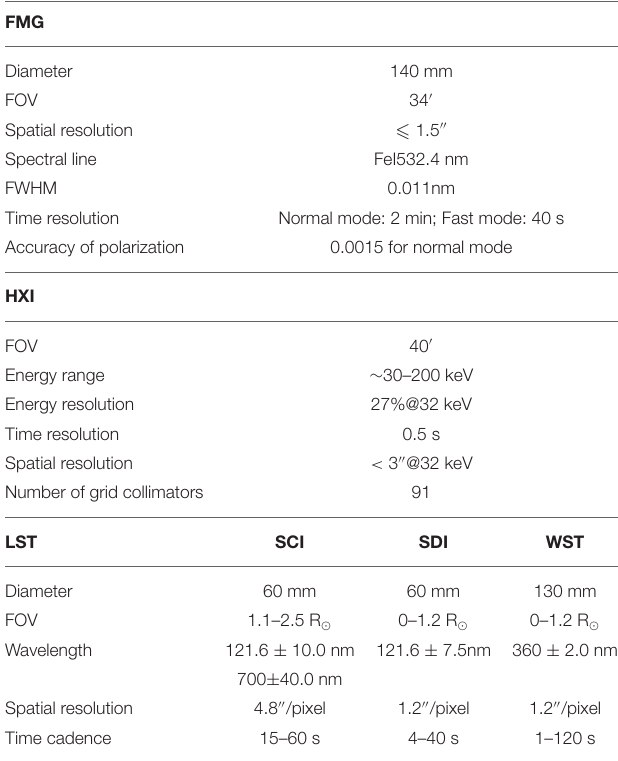
TABLE 1 | The main parameters of three instruments aboard ASO-S. This table is adapted from Gan et al.